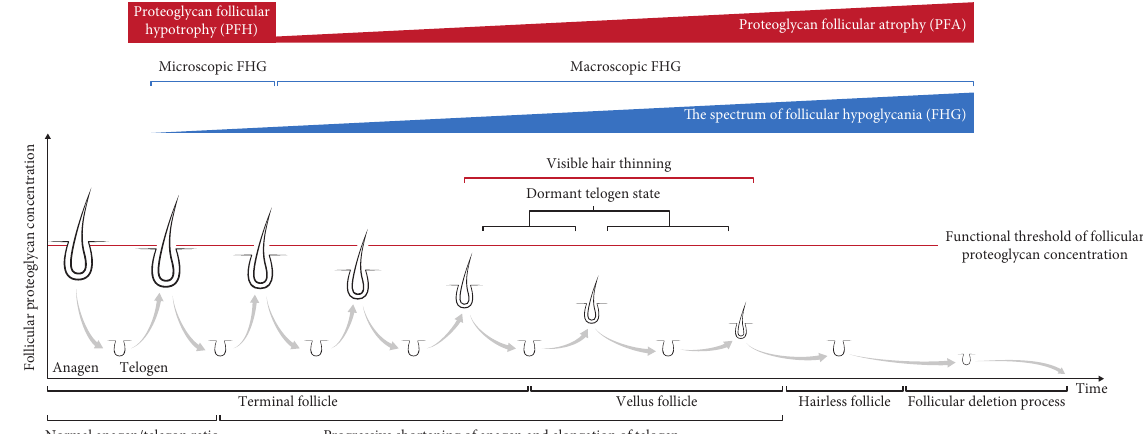
Figure 2: This illustration demonstrates the functional effects of dysregulated turnover of follicular proteoglycans on the growth and cycling behaviour of the hair follicles. As the ability of follicular cells to synthesise proteoglycans diminishes, the anagenic concentration of bioactive proteoglycans falls below a certain threshold leading to progressive degrees of follicular hypoglycania (FHG). Advanced FHG can result in a gradual increase in telogen to anagen duration ratios and decline in the maximum size of the hair follicles. At its early stages, FHG underlies subclinical alterations in the size of the follicle, called proteoglycan follicular hypotrophia (PFH), which advances to more significant stages, referred to as proteoglycan follicular atrophy (PFA). PFA is presented clinically as progressive hair